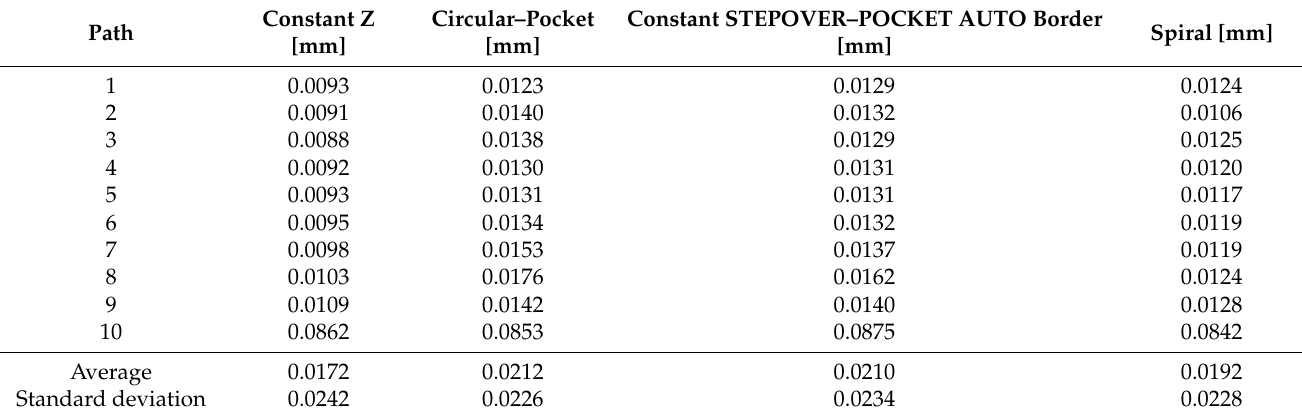
Figure 16. Roundness deviations ( a ) constant step over-pocket auto border strategy; ( b ) spiral strategy. Table 4. Roundness deviations using the UPR filter.